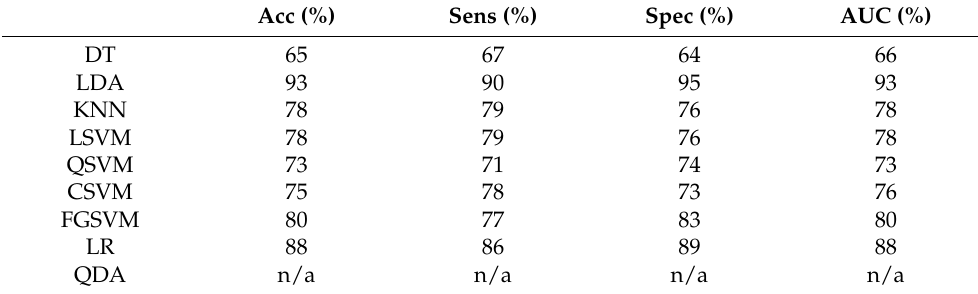
Table 9. Results for the LSDL for Dataset 1.